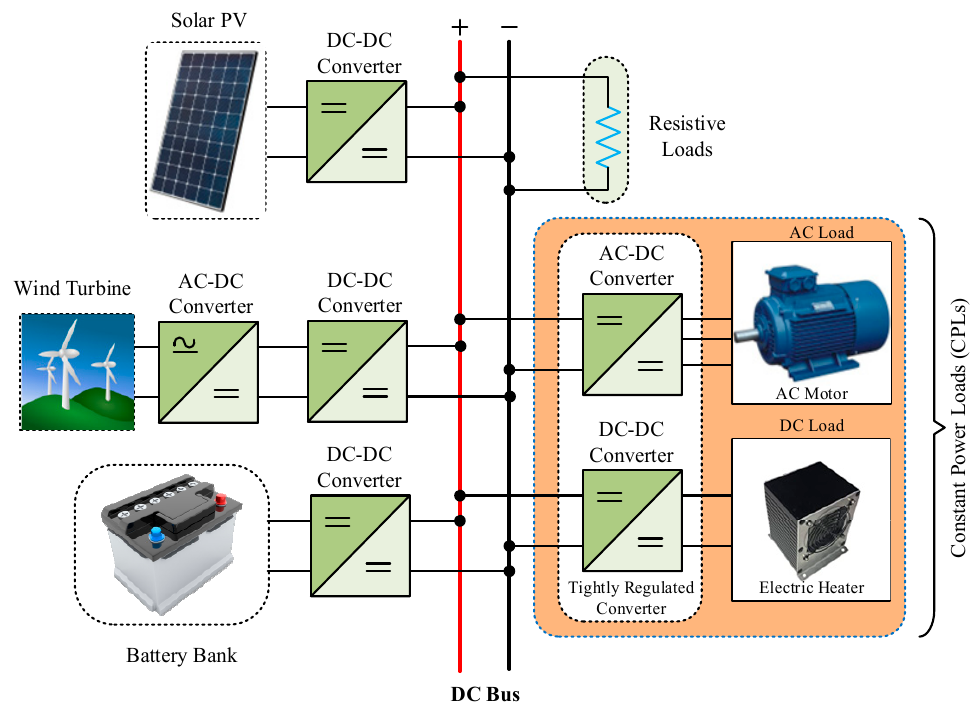
Figure 1. Architecture of DC Microgrid.